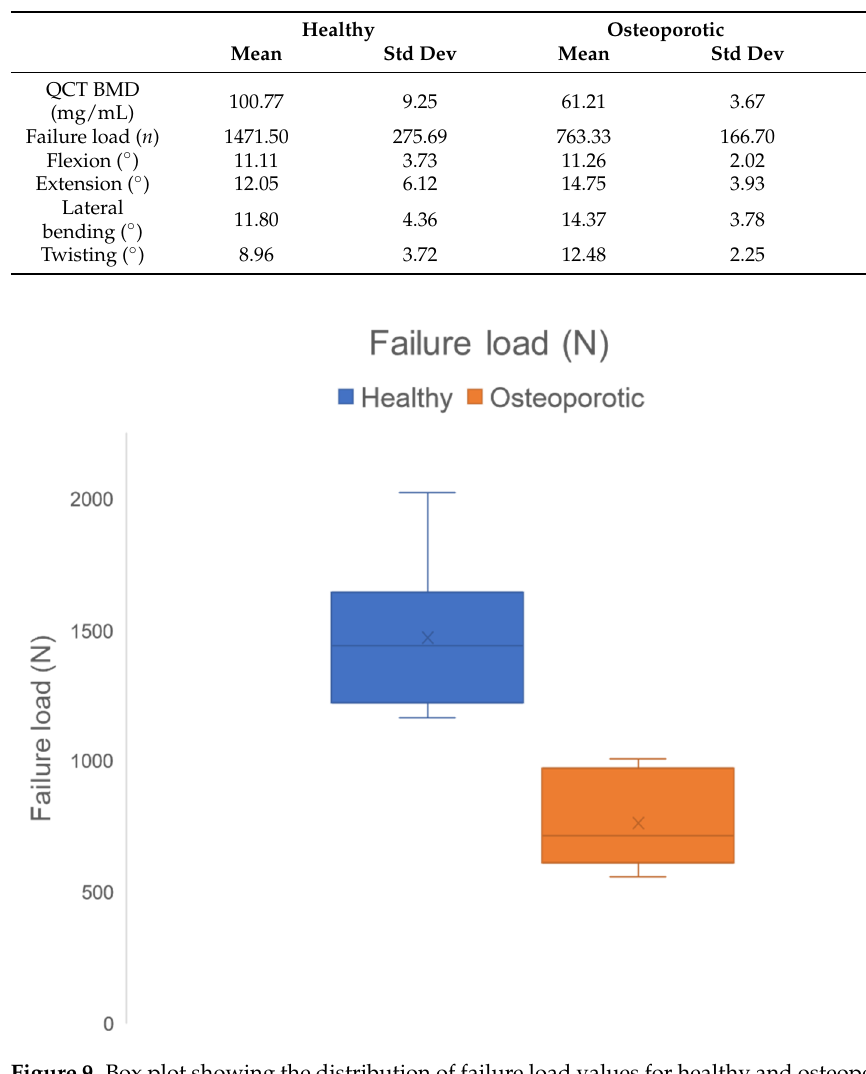
Figure 9. Box plot showing the distribution of failure load values for healthy and osteoporotic lumbar spine models.